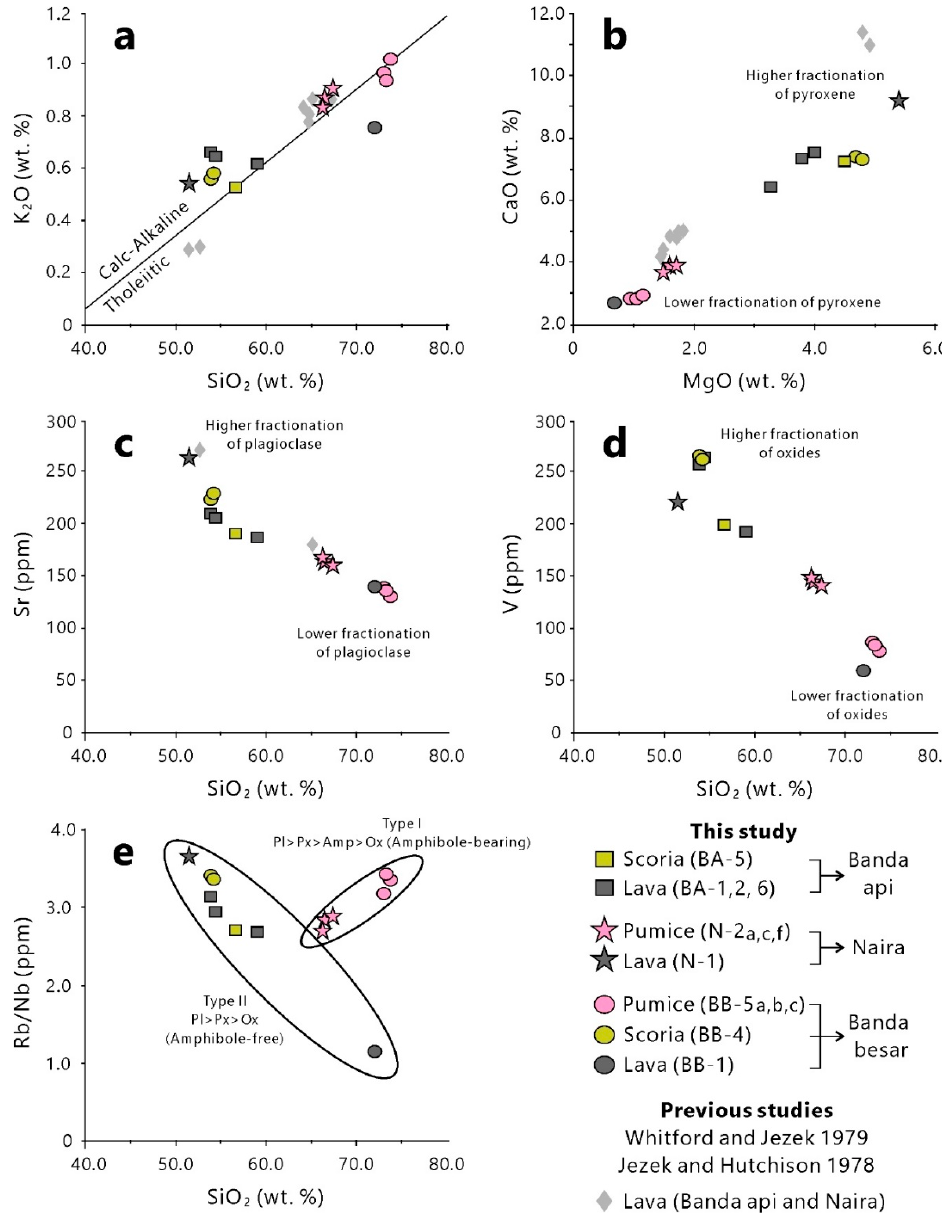
Figure 13. ( a ) BVC rocks are plotted in the transitional zone between tholeiitic and low-K magma affinities. ( b ) Positive correlation between MgO and CaO. ( c , d ) SiO 2 is found to be negatively correlated with Sr and V. ( e ) Two magma types were identified on the basis of the Rb/Nb and SiO 2 plot. Type I (showing a positive correlation) is exclusive to caldera-forming eruptions and includes amphibole in the phenocryst phase. Type II (showing a negative correlation) corresponds to non-caldera-forming eruptions and contains no amphibole.